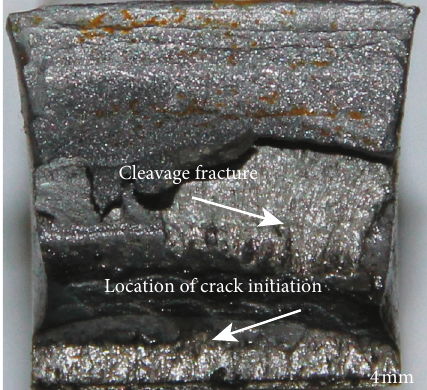
Figure 8: Macroscopic fracture morphology of sample